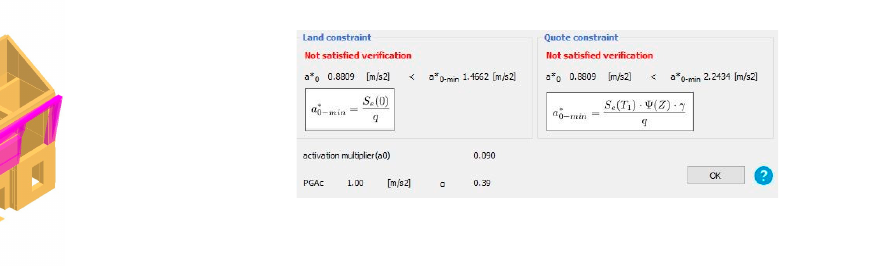
Figure 16. Local mechanism out-of-plane failure of the façade wall.